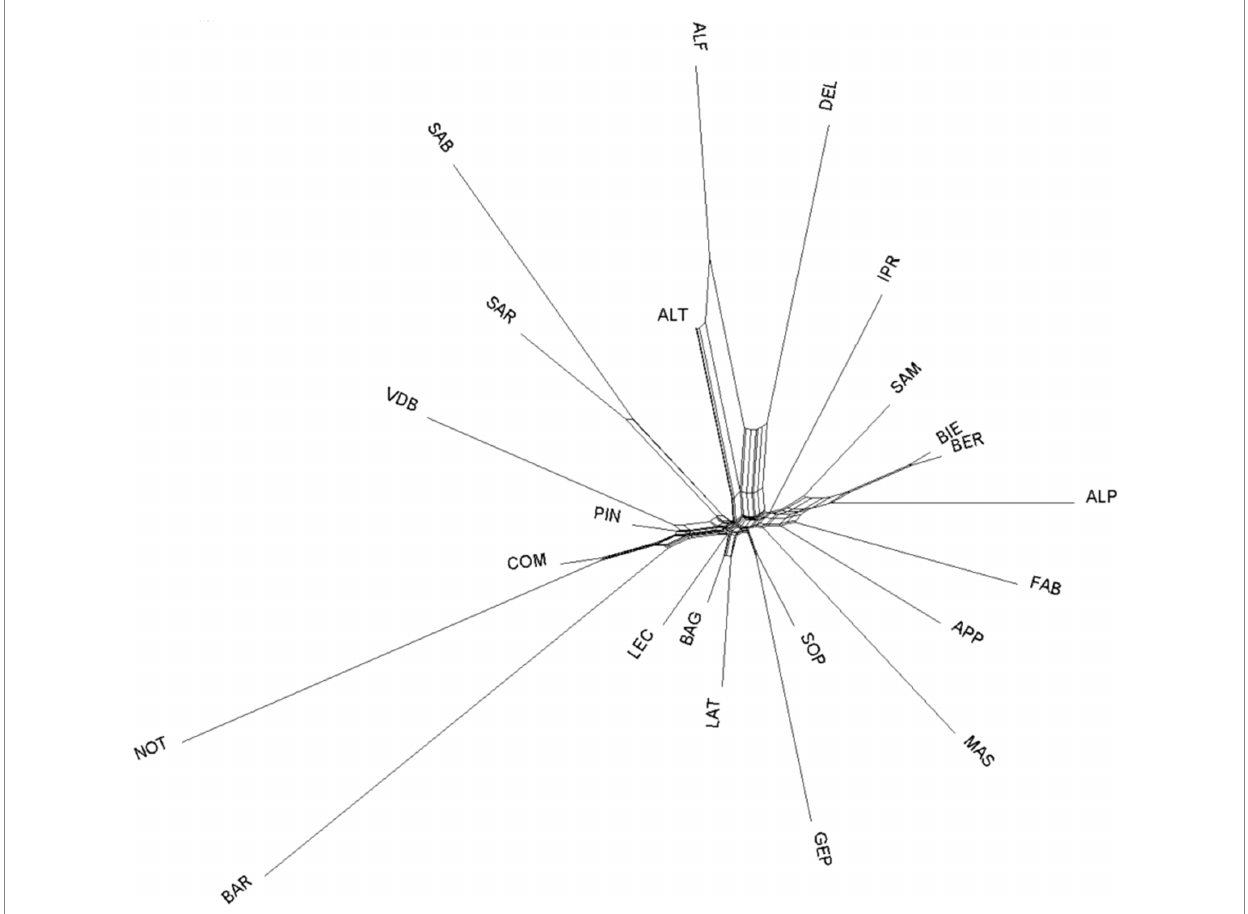
FIGURE 3 Neighbor-Net based on Reynolds’ pairwise genetic distances among the 23 sheep breeds (ITAPOP). For full definition of the dataset, see Table 1.